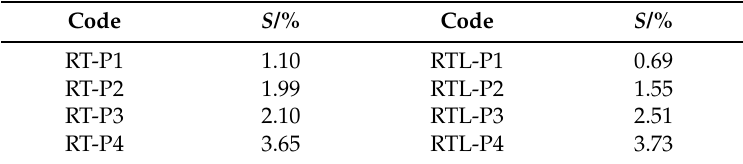
Table 2. Corrosion mass loss ratio ( S ) of corroded reinforcement.